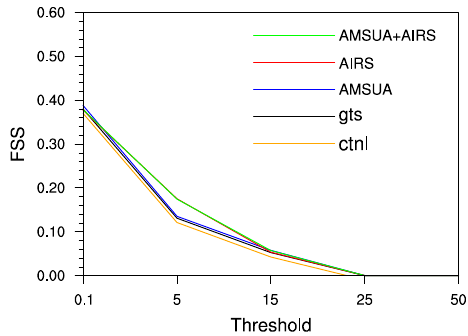
Figure 10. Fraction skill score (FSS) score of cumulative precipitation for 6 h with thresholds of 0.1, 5, 15, 25 mm. 15, 25